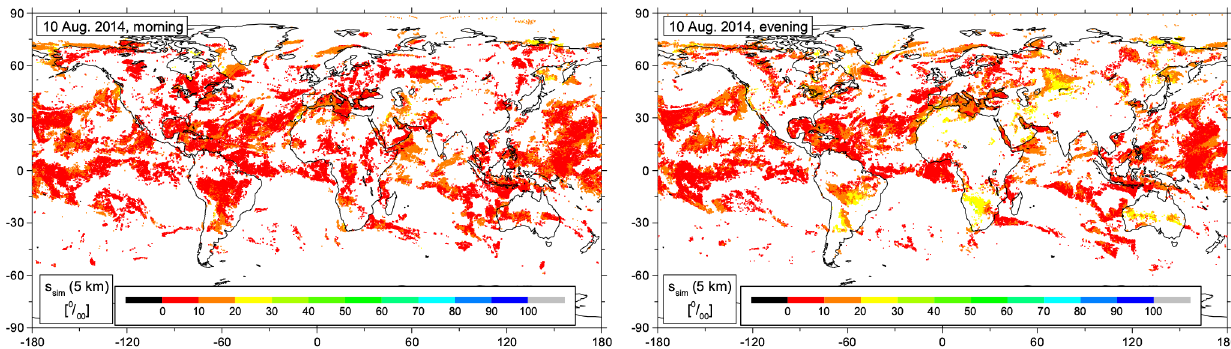
Figure 10. Example of the daily geographical distribution of s sim ( 5km ) for those situations that fulfil the sensitivity criterion (s err ( 5km ) < 50‰). The calculation of S sim is made according to Eq. (8). Left panels show the morning overpass and the right panels the evening overpass for 10 August 2014, i.e. same coverage as in Fig.